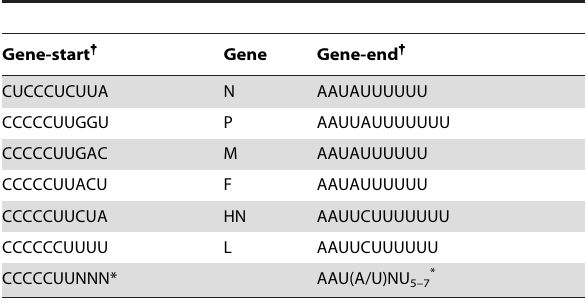
Table 2. The gene-start and gene-end sequences of APMV-5 strain Kunitachi.